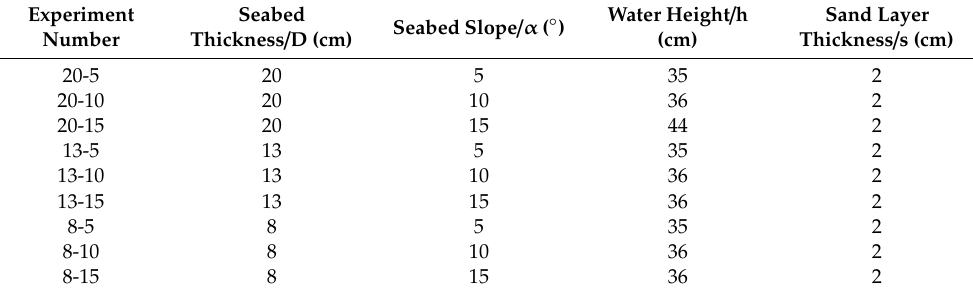
Table 1. The parameters used for the test groups.